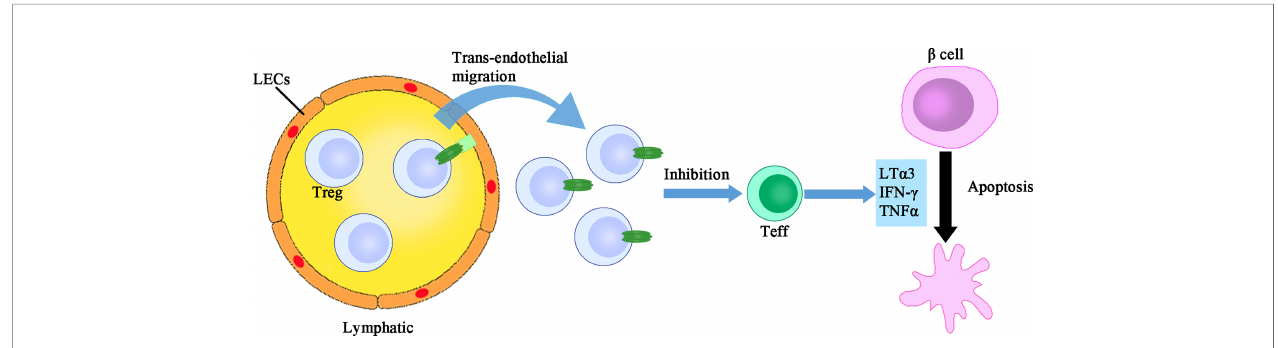
FIGURE 2 | The direct immune regulatory function of LTs. LTs exert dual immune regulatory roles. One the one hand, LT a 1 b 2 expressing Treg cells have more active trans-endothelial migration which facilitates their suppression of islet in fi ltrating Teff cells. On the other, LT a 3 assists in the direct killing of b cells, although the toxicity of LT a 3 alone is limited. LEC, lymphatic endothelial cells; Treg, regulatory T cells; Teff, effector T